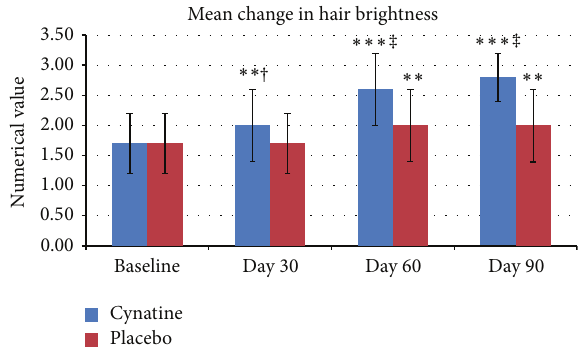
Figure 3: Mean change in hair brightness from baseline for placebo and Cynatine HNS. ∗∗ 𝑃 < 0.01 and ∗∗∗ 𝑃 < 0.001 within group to baseline; † 𝑃 < 0.05 , ‡ 𝑃 < 0.001 between groups to